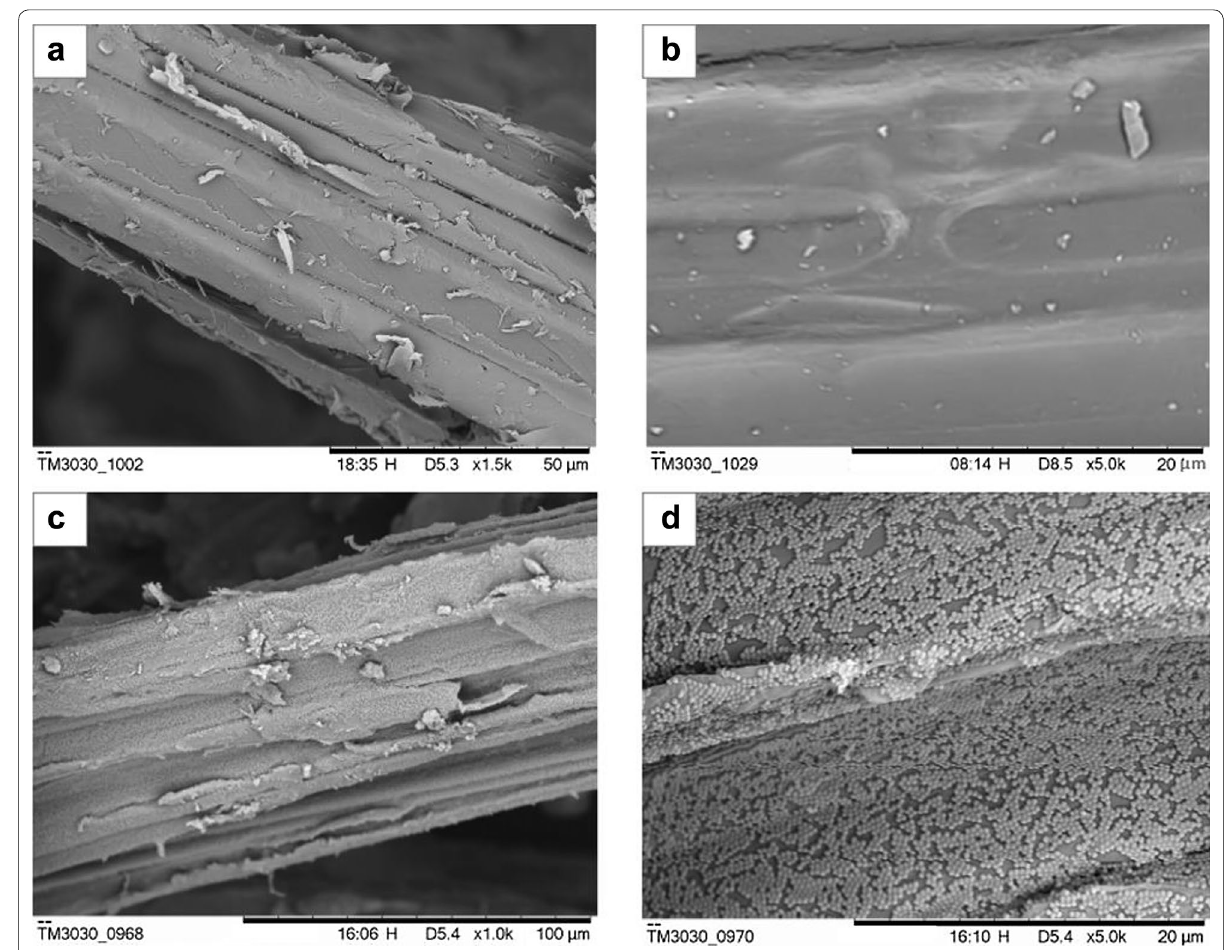
Fig. 2 SEM images of the raw corn straw fiber ( a , b ) and superhydrophobic/superoleophilic corn straw fiber ( c , d ) at different magnifications. Com‑ pared to raw corn straw fiber, SiO 2 particles compactly deposit on the superhydrophobic/superoleophilic corn straw fiber